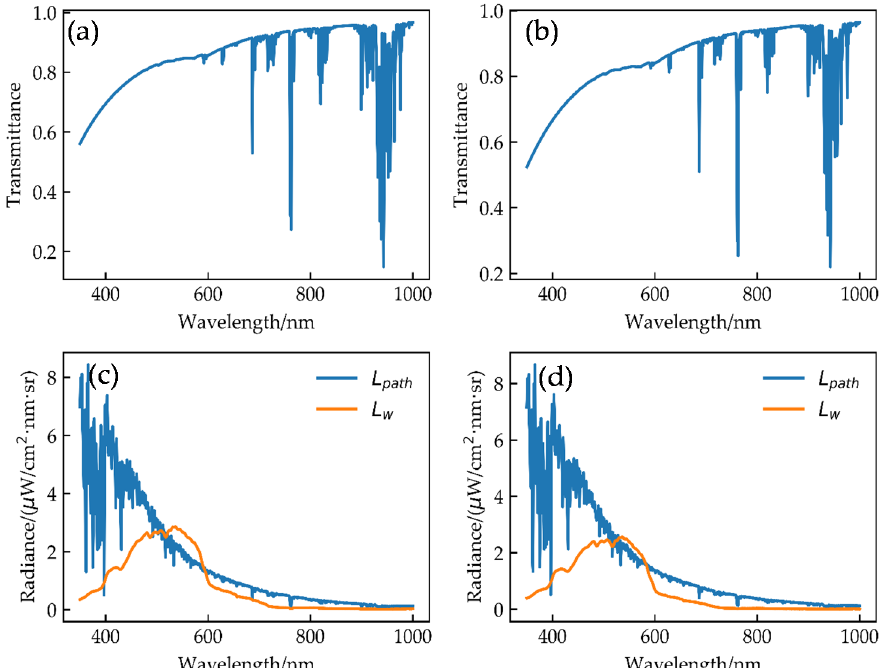
Figure 10. ( a ) Atmospheric transmittance at 14:38 (UTC + 08:00), 18 August 2018; ( b ) atmospheric transmittance at 14:43 (UTC + 08:00), 23 August 2018; ( c ) multiple scattering radiance and normalized water-leaving radiance at 14:38 (UTC + 08:00), 18 August 2018; ( d ) multiple scattering radiance and normalized water-leaving radiance at 14:43 (UTC + 08:00), 23 August 2018.